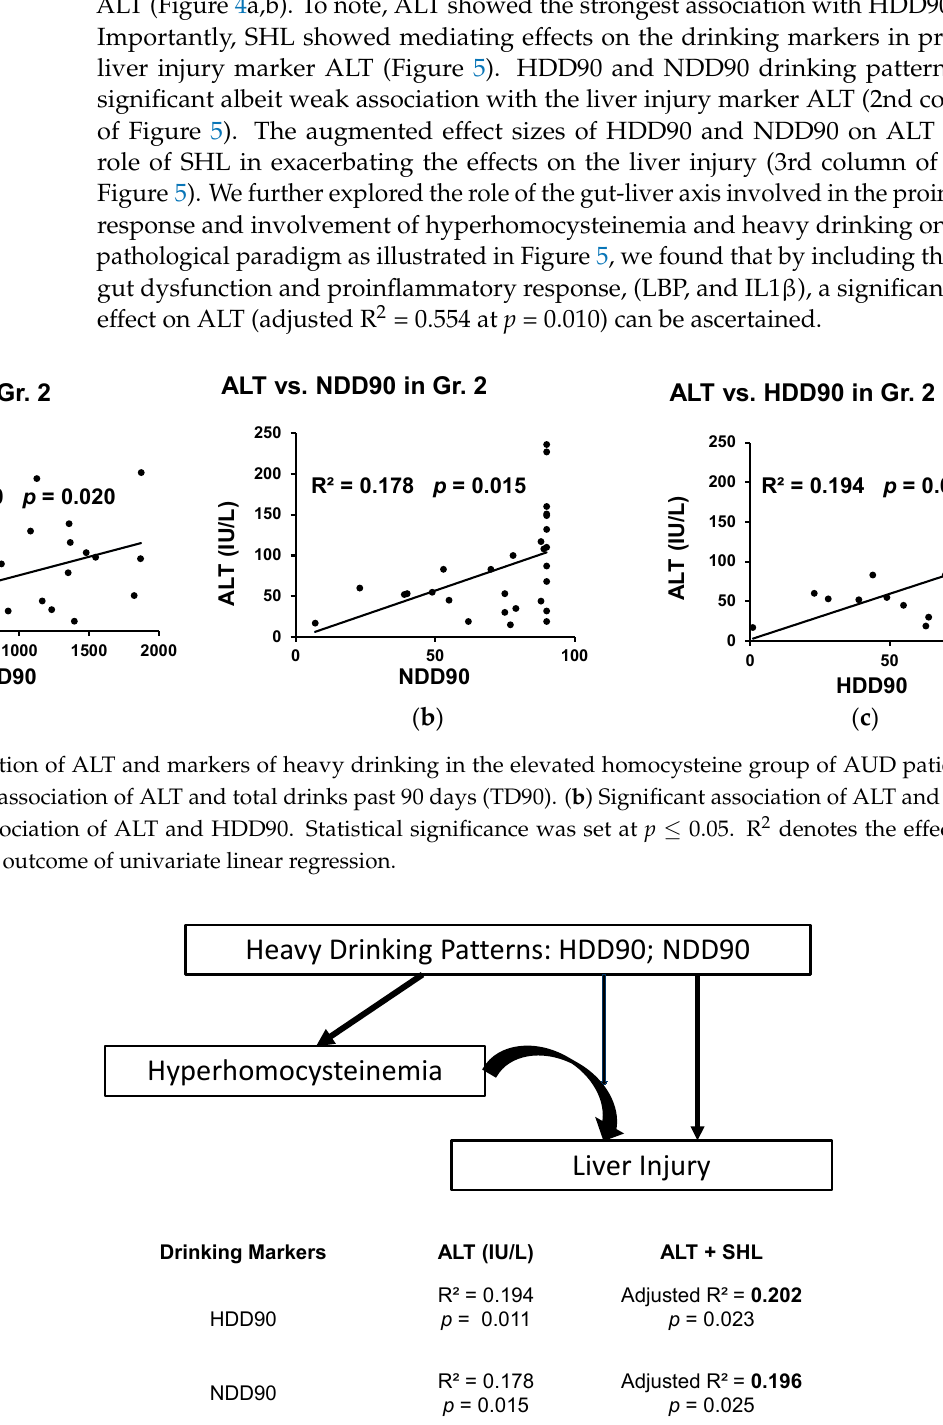
Figure 5. Direct response of the drinking markers on liver injury and the mediating role of the serum homocysteine level (SHL) in AUD patients with high homocysteine levels (Gr. 2). The indirect role of SHL shows higher effects of association together with heavy drinking in the exacerbation of the liver injury. Statistical significance was set at p ≤ 0.05. R 2 denotes univariate effect sizes. Adjusted R 2 (in Bold font) denotes the effect of the relationship as an outcome of multivariate linear regression with the added variable of